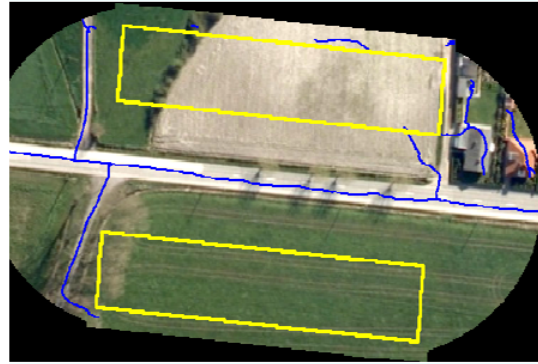
Figure 1: 2D line extraction result (blue) and region mask (yellow) for computing entropy E